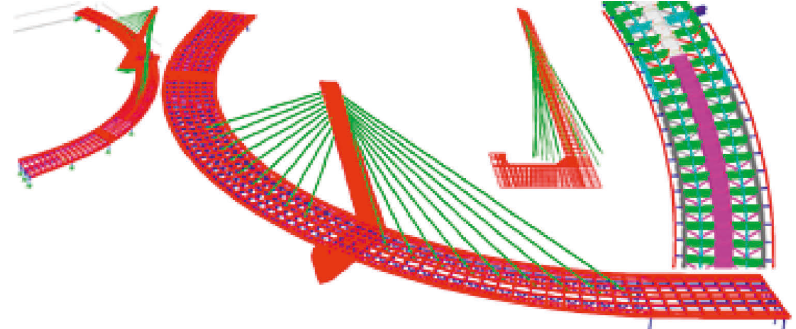
Figure 9: Finite element model of the curved composite stay-cabled bridge, the Marghera